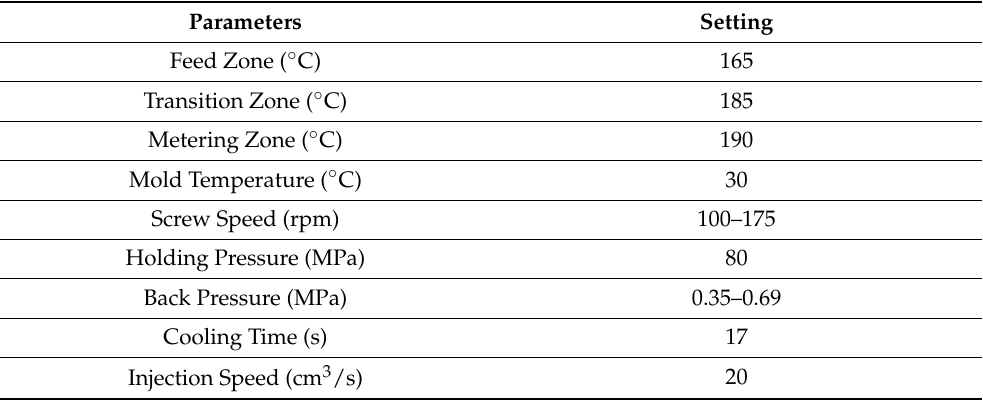
Table 1. The parameters for injection molding for